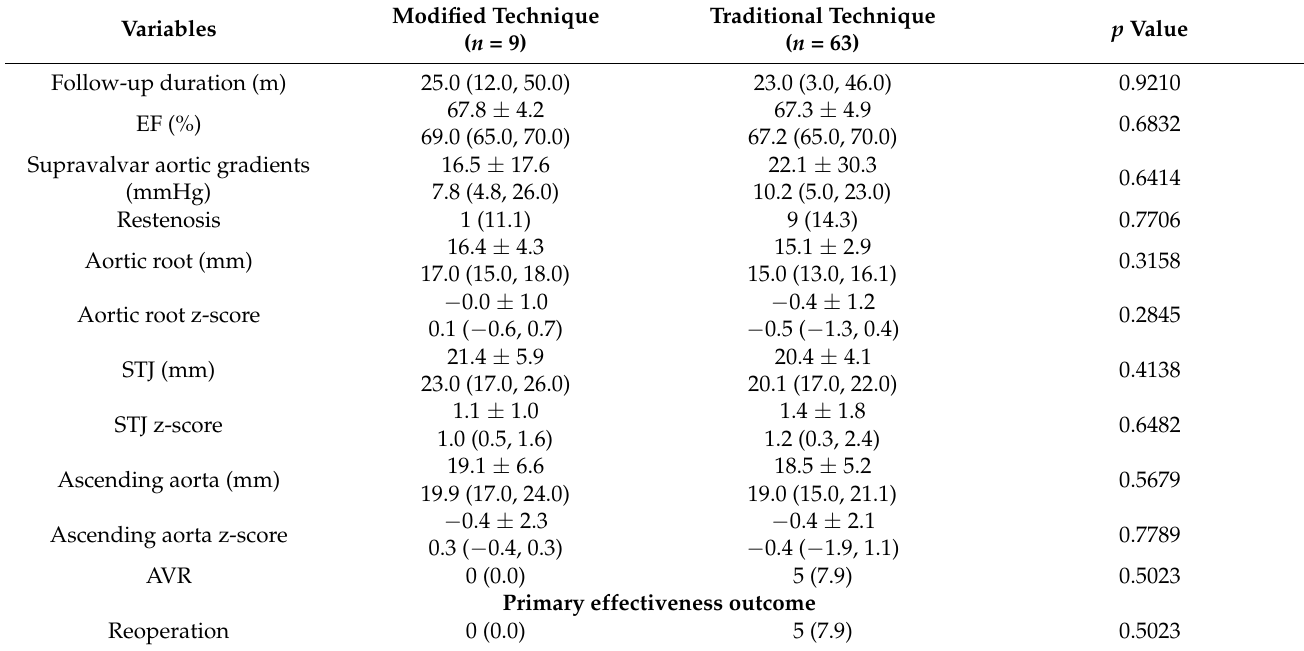
Table 3. Follow-up characteristics of the patients with modified and traditional